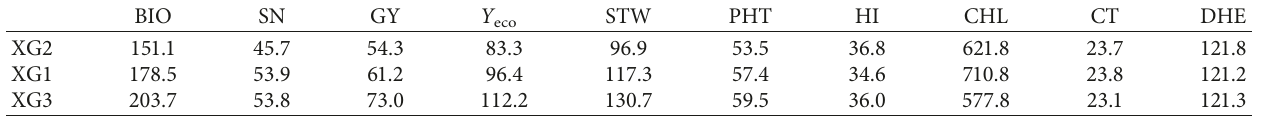
Table 7: Cluster means for the 10 measured traits of the 56 durum wheat genotypes. BIO